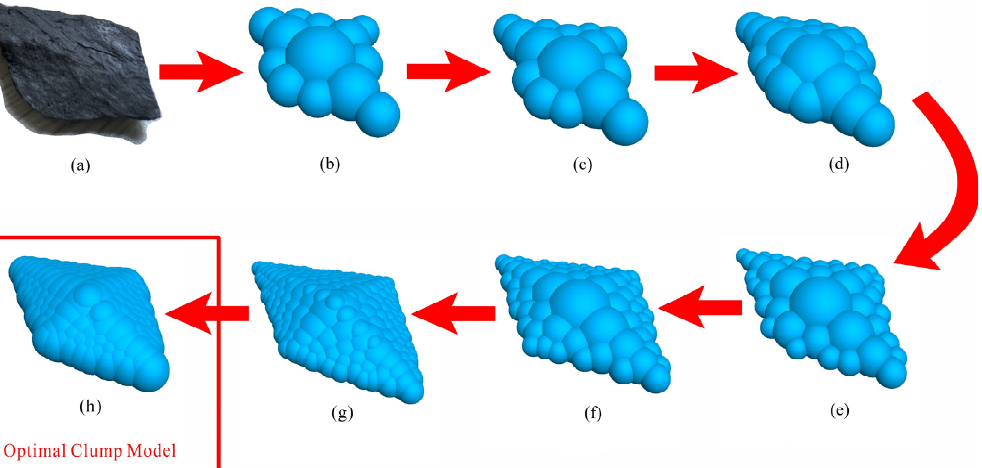
Figure 5. Generation and evolution effects of clump 2. ( a ). Coal gangue real shot; ( b ). ratio = 0.5, distance = 100; ( c ). ratio = 0.5, distance = 110; ( d ). ratio = 0.5, distance = 130; ( e ). ratio = 0.3, distance = 100; ( f ). ratio = 0.3, distance = 120; ( g ). ratio = 0.3, distance = 145; ( h ). ratio = 0.5, distance = 160.